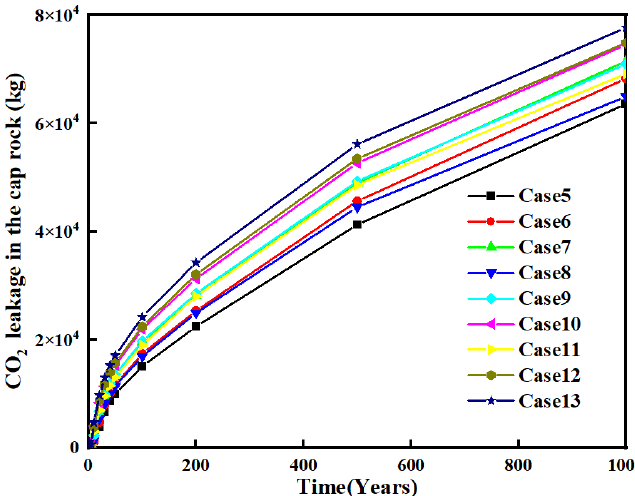
Figure 13. CO 2 invasion curve.